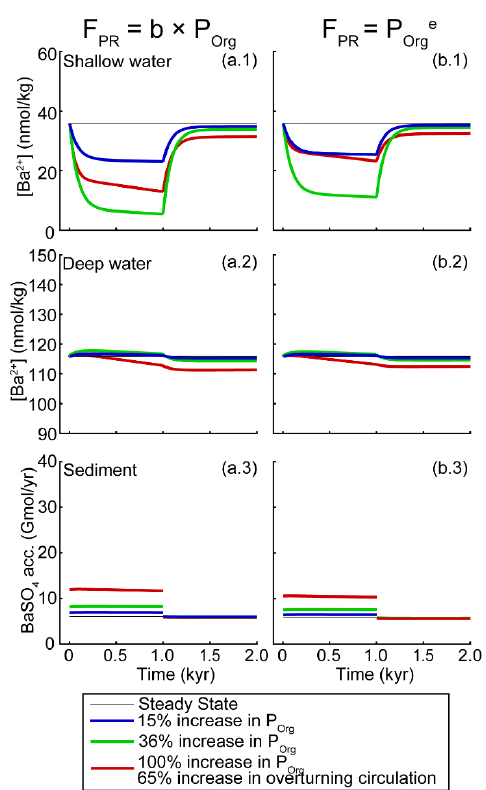
Figure 7. Box model results with decreased terrestrial input and zero hydrothermal input. Fluxes within the surface and deep water boxes are also changed to maintain mass balance in the model. The two columns ( a, b ) show results using different relationships of F PR . The three rows ( 1, 2, 3 ) show the dissolved concentration of Ba in surface water (top; a.1, b.1 ), the dissolved concentration of Ba in deep water (middle; a.2, b.2 ), and the accumulation of barite (BaSO 4 ) in the sediment (bottom; a.3, b.3 ). The left column shows results using a linear relationship for F PR ( a.1, a.2, a.3 ), the right column shows results using an exponential relationship (b.1, b.2, b.3). Different colors represent scenarios of perturbations (see legend), each running for 1 kyr, then a return to steady-state conditions.